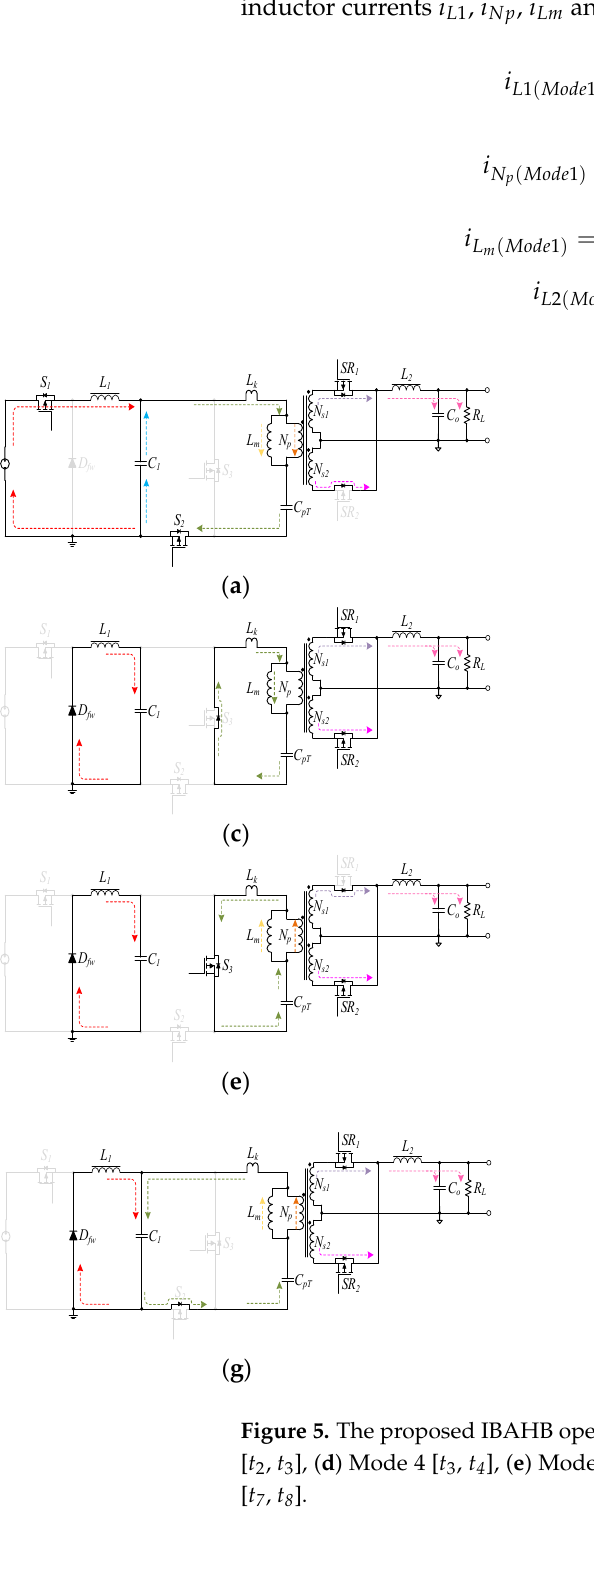
T Figure 6. The switching sequence of the proposed topology. Mode 1 [0, DT ] The main switches S 1 and S 2 are in the turned-on state. The input voltage source transfers energy to the inductor L 1 and capacitor C pT . At the same time, the capacitor C 1 also provides energy to C pT through S 2 . On the secondary side, the output inductor L 2 and the output capacitor C o are charging from the transformer and the C o supplies energy to load R L . The equivalent circuit is shown in Figure 7 and the formulas can be expresses as:  () =   −   −   =   −